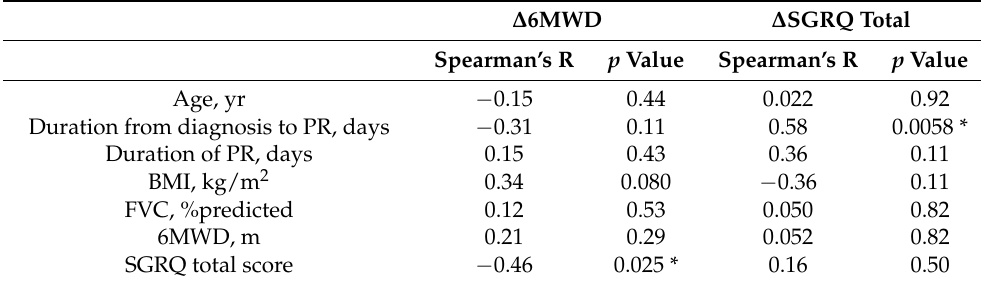
The results of the ROC analyses are shown in Table 5. The ROC curves of clinical data that were associated with the improvement over the MCID of the SGRQ total score or 6MWD are shown in Figure 1. Less than cut-off level of the duration from diagnosis of FILD to the start of PR was significantly associated or tended to be associated with improvement over the MCID of the SGRQ total score after PR (MCID = 4 points, sensitivity = 0.93,